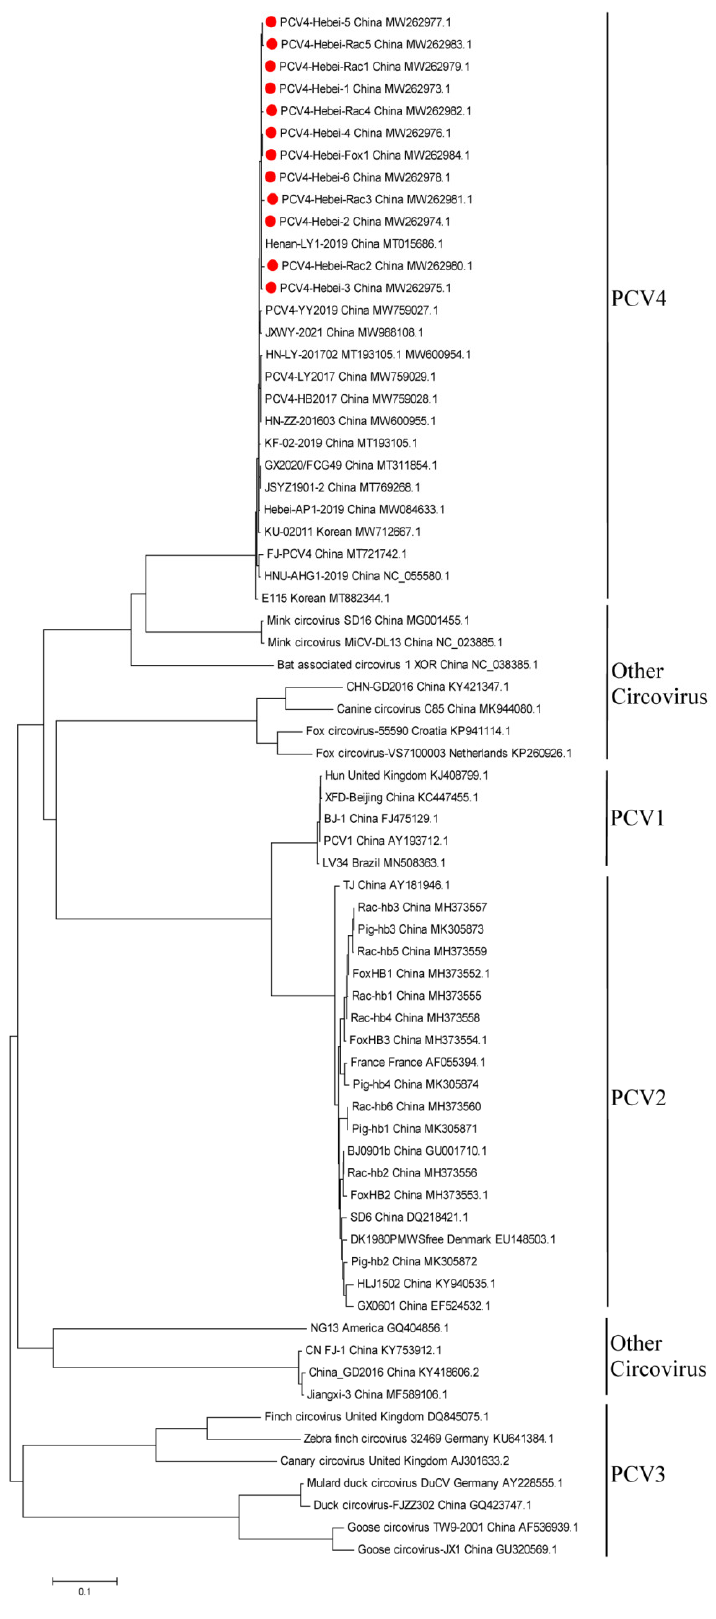
Figure 2. Phylogenetic tree of the whole genome sequences of PCVs. The tree was constructed using MEGA X software with neighbor-joining methods and 1000 replicate sets on bootstrap analysis. The twelve PCV4 strains obtained in this study were labelled with red circular.